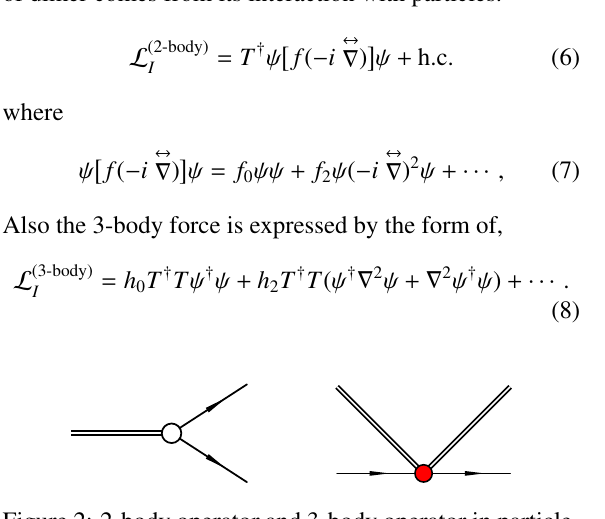
Figure 2: 2-body operator and 3-body operator in particle- dimer formalism